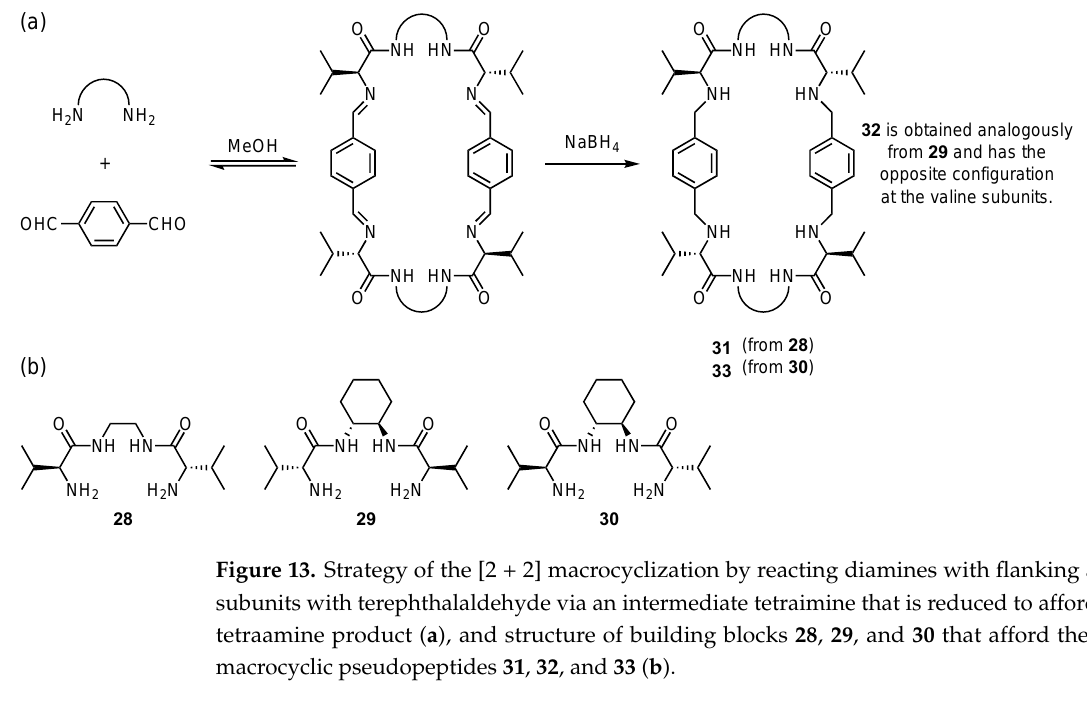
32 is obtained analogously from 29 and has the opposite configuration at the valine subunits.